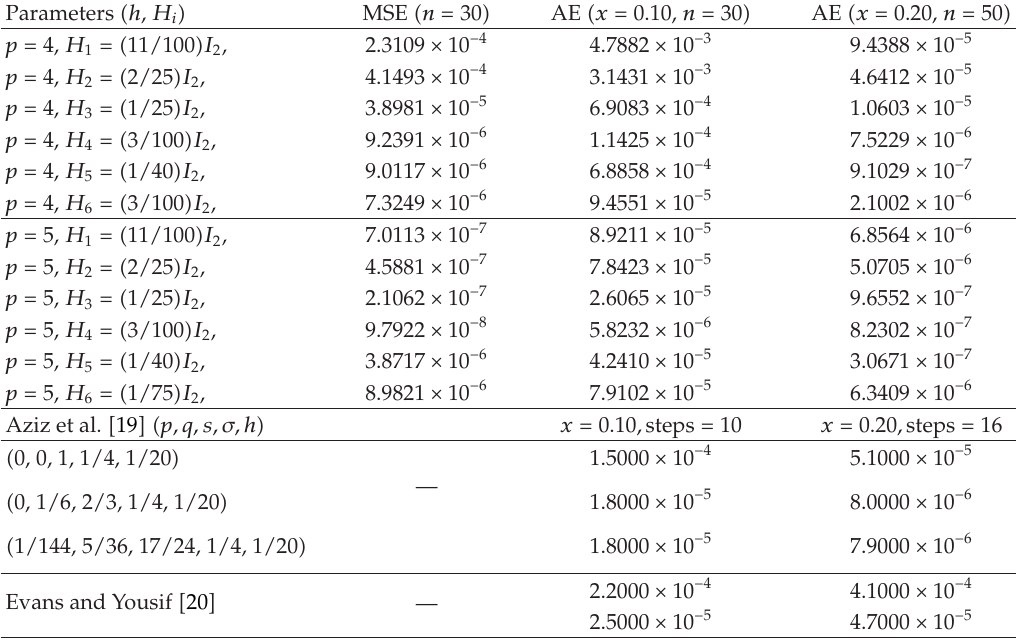
Table 2: Mean square errors (cid:2) MSEs (cid:3) with di ff erent values of p , H given n (cid:8) 30 and absolute errors (cid:2) AE (cid:3) given n (cid:8) 30, 50 in Example 4.2, I 2 : unit matrix of two